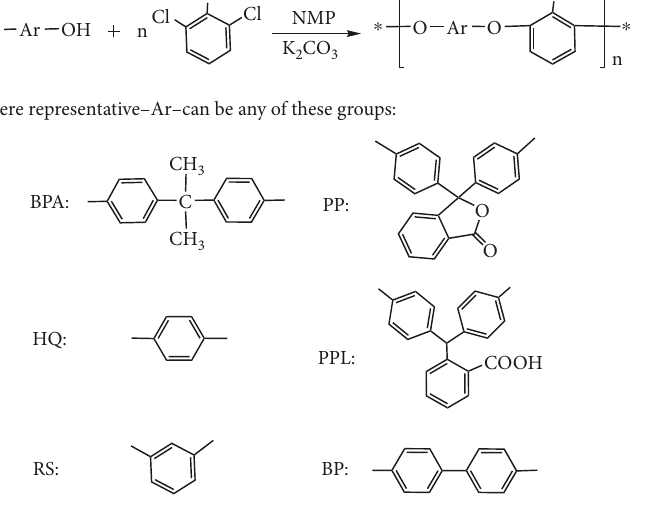
Figure 1: Synthesis route of PEN.